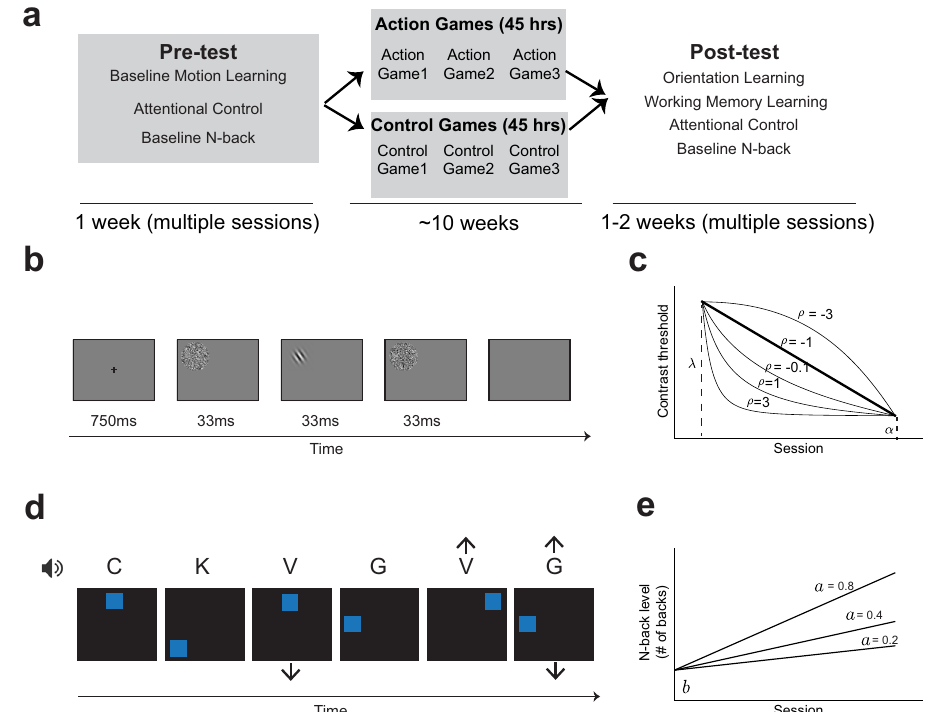
Fig. 1 Intervention protocol, learning tasks, and learning models. a illustrates the design of the protocol employed in both the initial (Study 1) and the replication (Study 2) intervention studies. During a pre-test, participants were assessed on a baseline motion learning task (perceptual), an attentional control task, and a baseline N -back task (Fig. S1A for additional task detail). Participants were then randomly assigned to one of two training groups – the action video game training group or the control video game training group. In each group, participants underwent three games each of 15 h. After a 45-h video game intervention, participants were assessed at post-test on the same attentional control task and baseline N -back task administered at pre-test, followed by an orientation learning task ( b ) and a working memory learning task ( d ). In the orientation learning task ( b ), participants were presented with a Gabor stimulus in one of four quadrants of the screen, and the Gabor stimulus was preceded and followed by two noise patterns. Participants pressed a button to report the direction of rotation (i.e., clockwise or counterclockwise) relative to a reference angle. In the working memory learning task ( d ), participants monitored two streams of simultaneously presented information – one auditory (letters) and one visual (blue squares) stimuli. They were